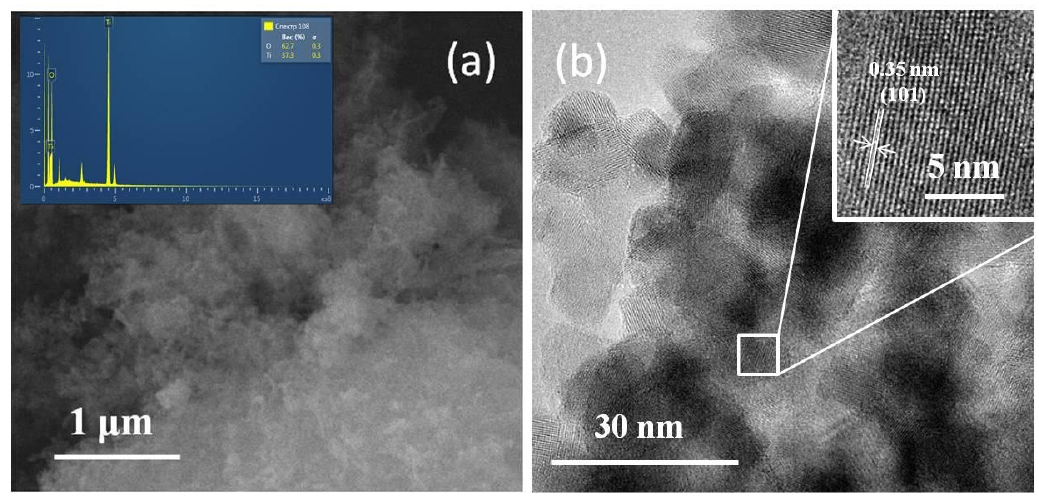
Figure 3. SEM ( a ) and HRTEM ( b ) images of TiO 2 nanoparticles.